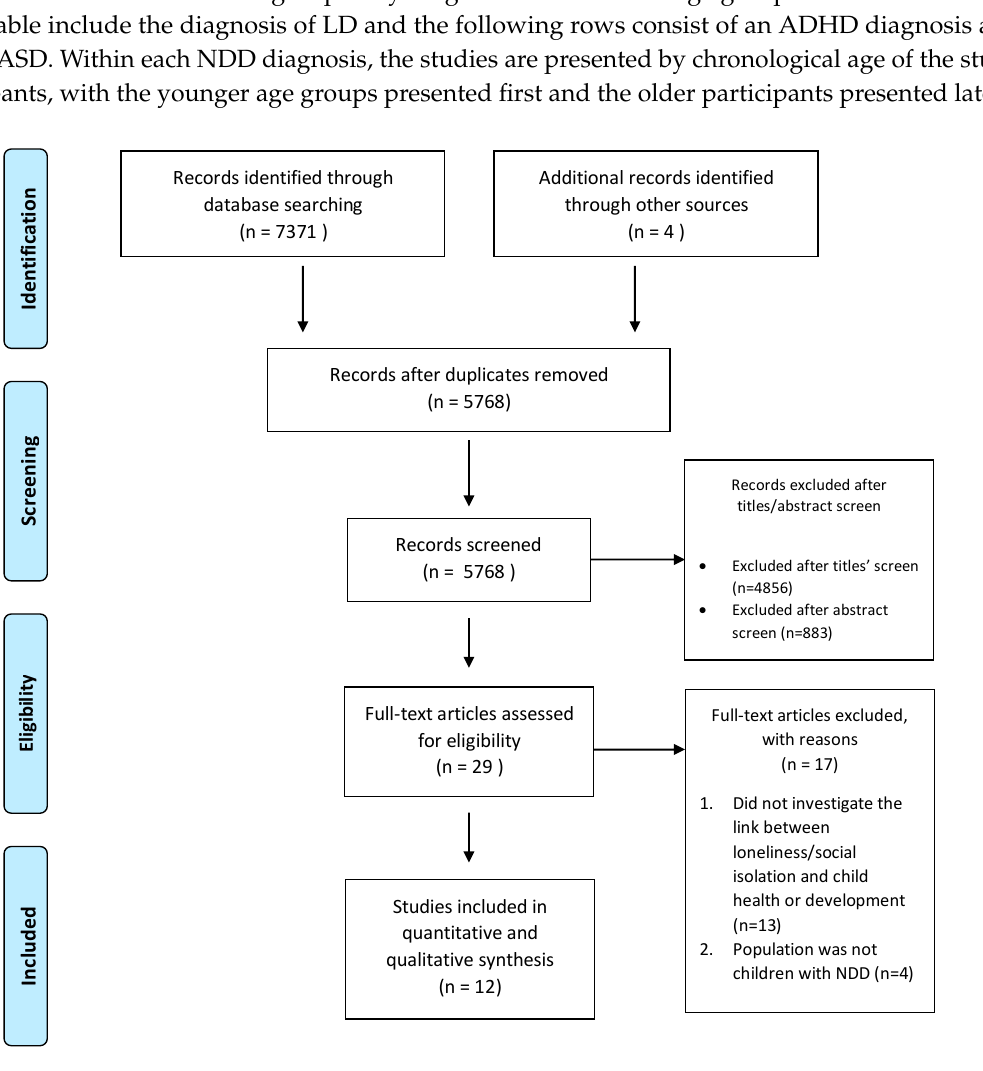
Figure 1. PRISMA flow diagram detailing the database searches, the number of abstracts screened, and the full texts retrieved .